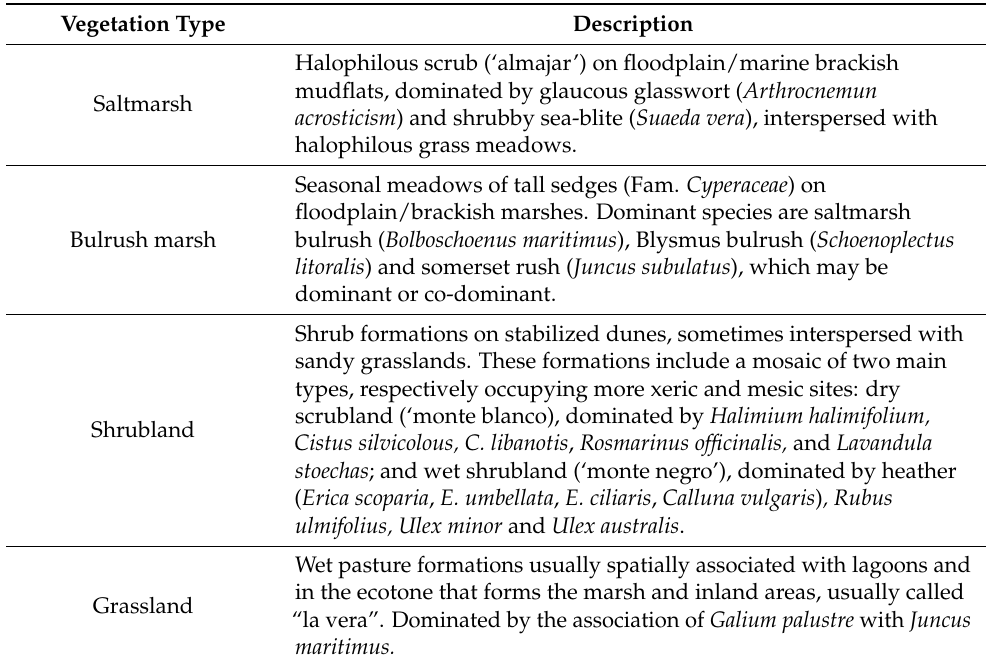
Table 1. Vegetation types and description of the characteristics and main species. Vegetation